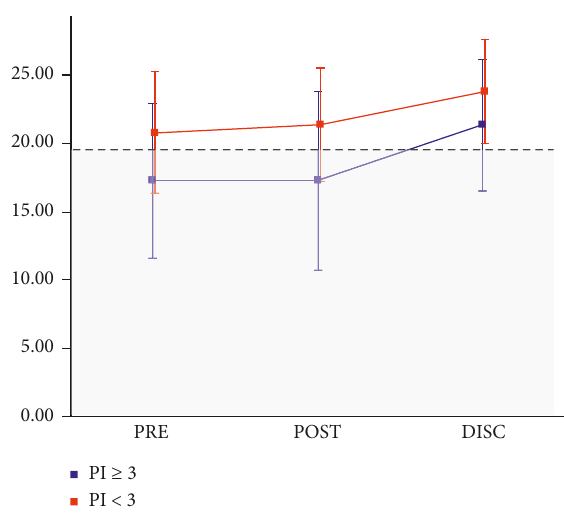
Figure 1: Mini-BESTest score changes in patients with and without postural instability. ∗ gray field indicates the risk of falls (mini- BESTest < 19 points). abbreviations: mini-BESTest, mini-balance evaluation systems test; PI, the point of movement disorder society unified Parkinson’s disease rating scale-part III 12 (postural stability score); PRE, preoperation period; POST, postoperation period; DISC, discharge